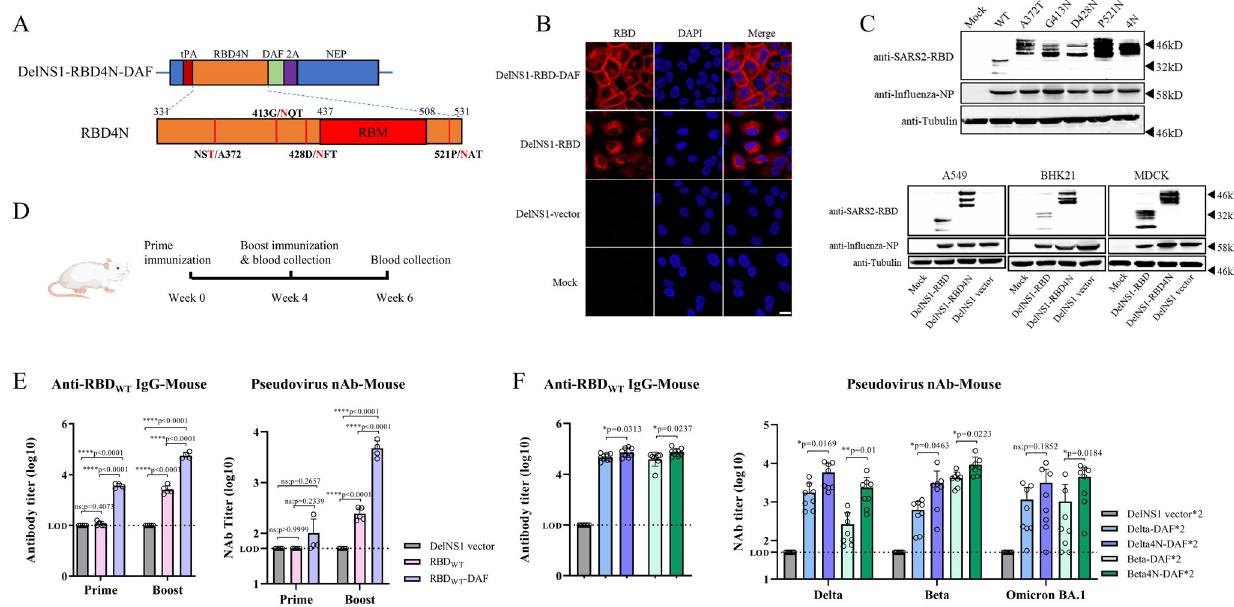
Fig. 1 | Construction and evaluation of DelNS1-RBD4N-DAF live attenuated virus vaccine candidates. A Illustration of construction of DelNS1-RBD4N-DAF. B Immuno fl uorescence(IF)assayof RBDexpressionwith orwithout DAF in MDCK cells. MDCK cells were mock infected or infected with DelNS1, DelNS1-RBD or DelNS1-RBD-DAFvirusesinthebackboneofA/California/4/2009(H1N1) 16 atanMOI of 1 for 10h and cells processed for IFA using antibodies speci fi c for RBD (red). Nuclei were stained with DAPI (blue). Images are representative of three indepen- dentexperiments. C Con fi rmationofN-glycosylationinRBDofDelNS1-RBD4N-DAF LAIV. MDCK cells were mock infected or infected with DelNS1-RBD (WT, lineage A virus), DelNS1-RBD with individual N-glycosylation mutations (A372T, G413N, D428N, or P521N), or DelNS1-RBD4N (4N) LAIV virus at an MOI of 1 for 10h. Cell lysates were analyzed by western blot using anti-RBD antibody and anti-NP anti- body.DelNS1-RBD,DelNS1-RBD4N,andDelNS1LAIVswerealsousedtoinfectA549, BHK21 and MDCK cells to detectthe expression of RBD. Images are representative of three independent experiments. D Schedule of immunization and blood col- lection for BALB/c mice. E Estimation of anti-RBD antibodies in mice prime-boost